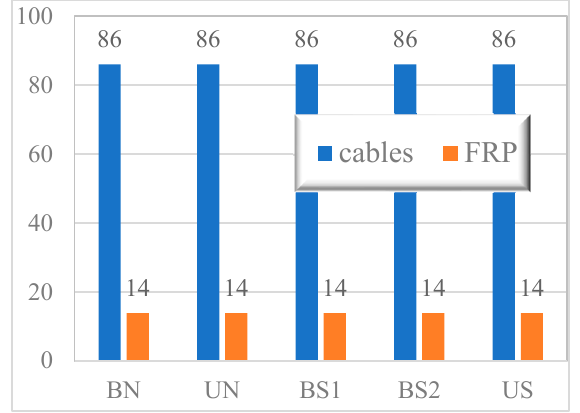
Figure 38. Strength contribution for 6 cables and 3 FRP laminates (2:1 ratio).